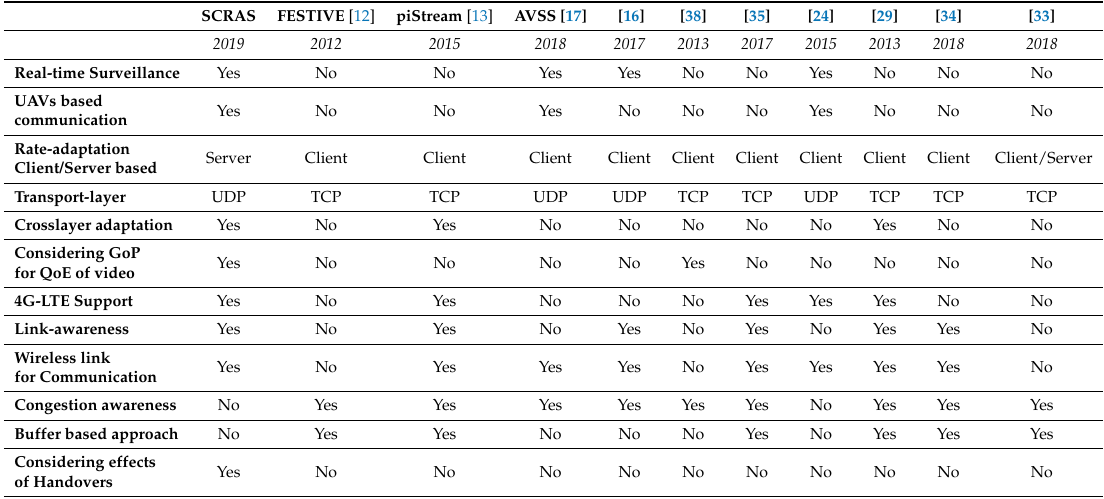
Table 1. Comparative analysis of the server-based crosslayer rate-adaptive scheme (SCRAS) with other related